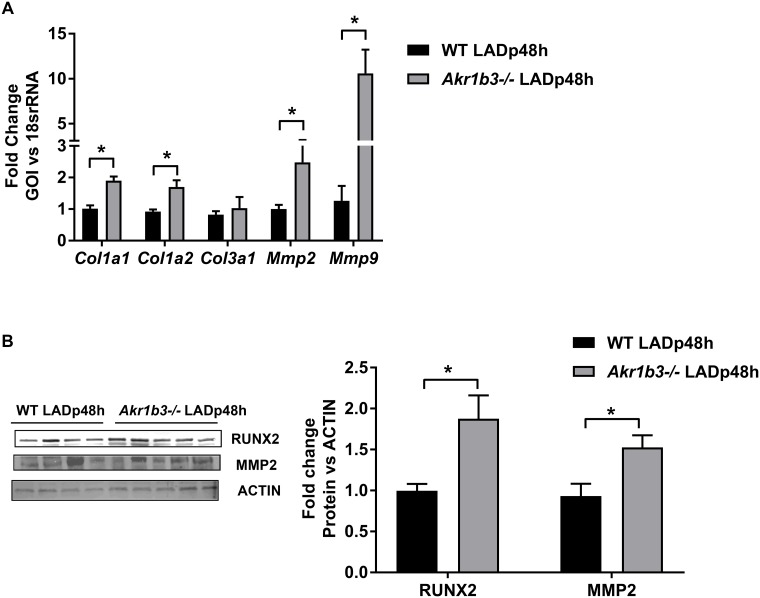
Increased expression of fibrotic factors in Akr1b3 null I/R mice hearts.RNA isolated from heart tissues from mice subjected to I/R. (A) qRT-PCR on collagens (Col1a1, Col1a2, Col3a1) and MMPs (Mmp2 and Mmp9), N = 5 mice/group. (B) Western blot analysis on RUNX2 and MMP2 expression in heart tissues subjected to I/R. N = 4/group. Error bars represent mean ± SEM. * p<0.05, unless otherwise noted.